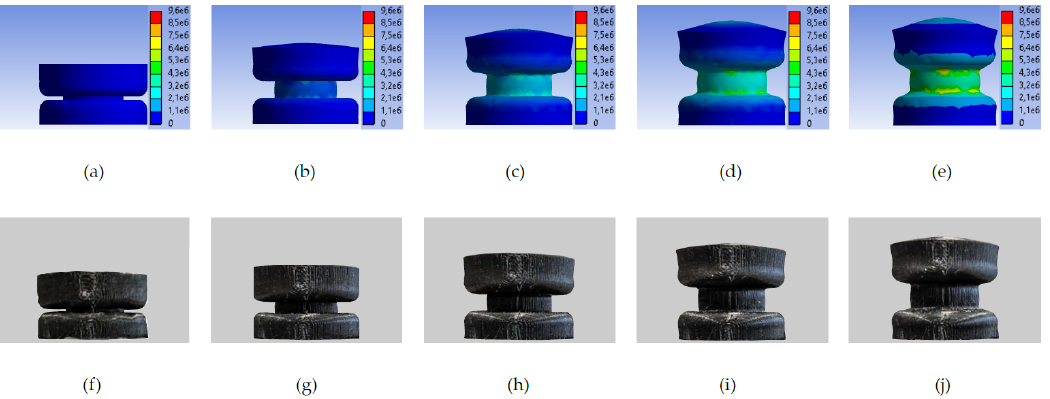
Figure 7. Soft actuator. Comparison of the FEA results at ( a ) 50 kPa, ( b ) 100 kPa, ( c ) 200 kPa, ( d ) 300 kPa and ( e ) 400 kPa with the behavior of the real actuator at ( f ) 50 kPa, ( g ) 100 kPa, ( h ) 200 kPa, ( i ) 300 kPa and ( j ) 400 kPa. The colorbar in FEA results represents Von Mises stress [Pa]. (Images used courtesy of ANSYS, Inc., Canonsburg, PA,